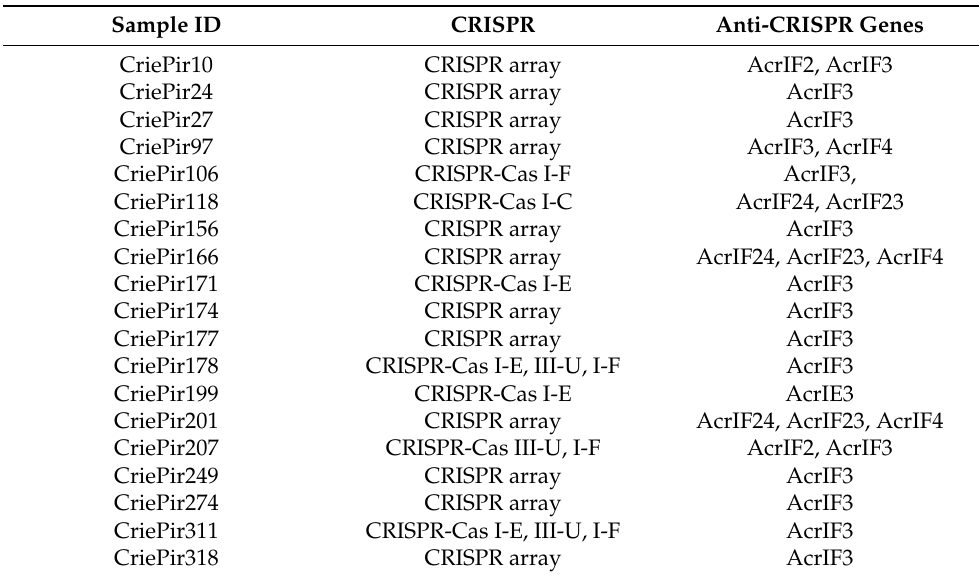
Table 1. List of the anti-CRISPR genes found in clinical CriePir P. aeruginosa isolates from a Moscow multidisciplinary medical